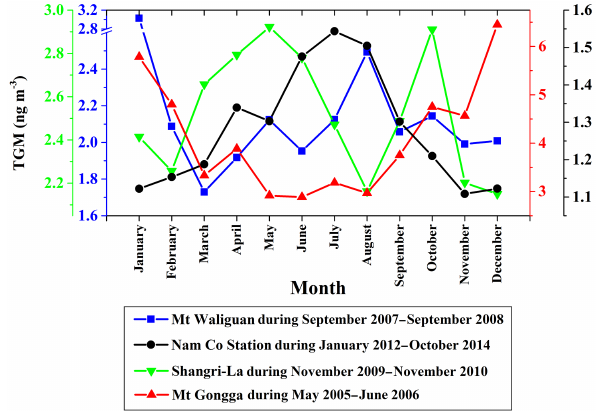
Figure 4. Monthly average GEM/TGM at Nam Co Station and three high-altitude background stations in the Northern Hemisphere (Denzler et al., 2017; Fu et al., 2016a; Ebinghaus et al., 2002) (av- erage TGM at Mace Head in green; average GEM at Pic du Midi in blue; median GEM at Jungfraujoch in red; average TGM at Nam Co Station in black); and monthly average surface ozone at Nam Co in